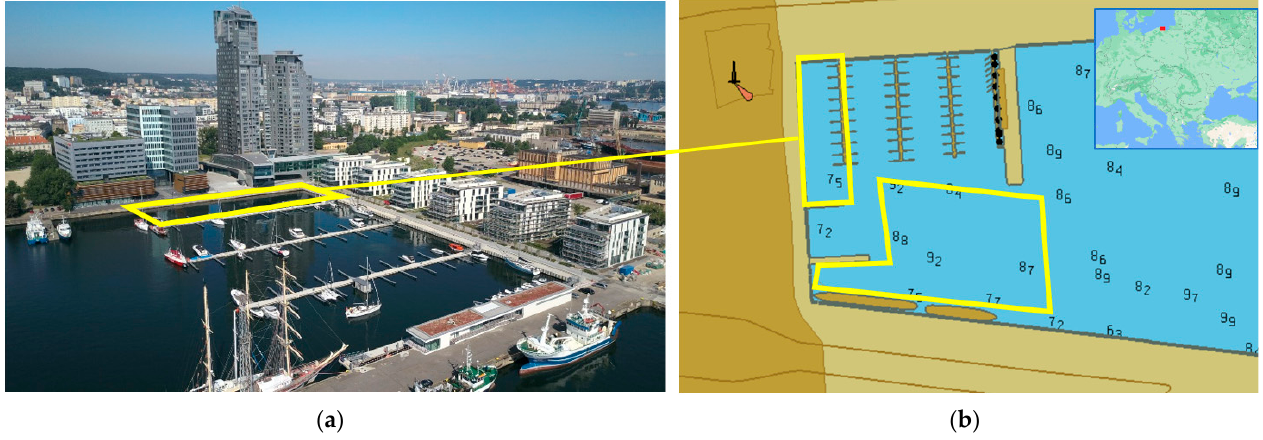
Figure 1. Area of the study: ( a ) view on Marina Yacht Park [77]; ( b ) chart of the marina and President’s Basin.